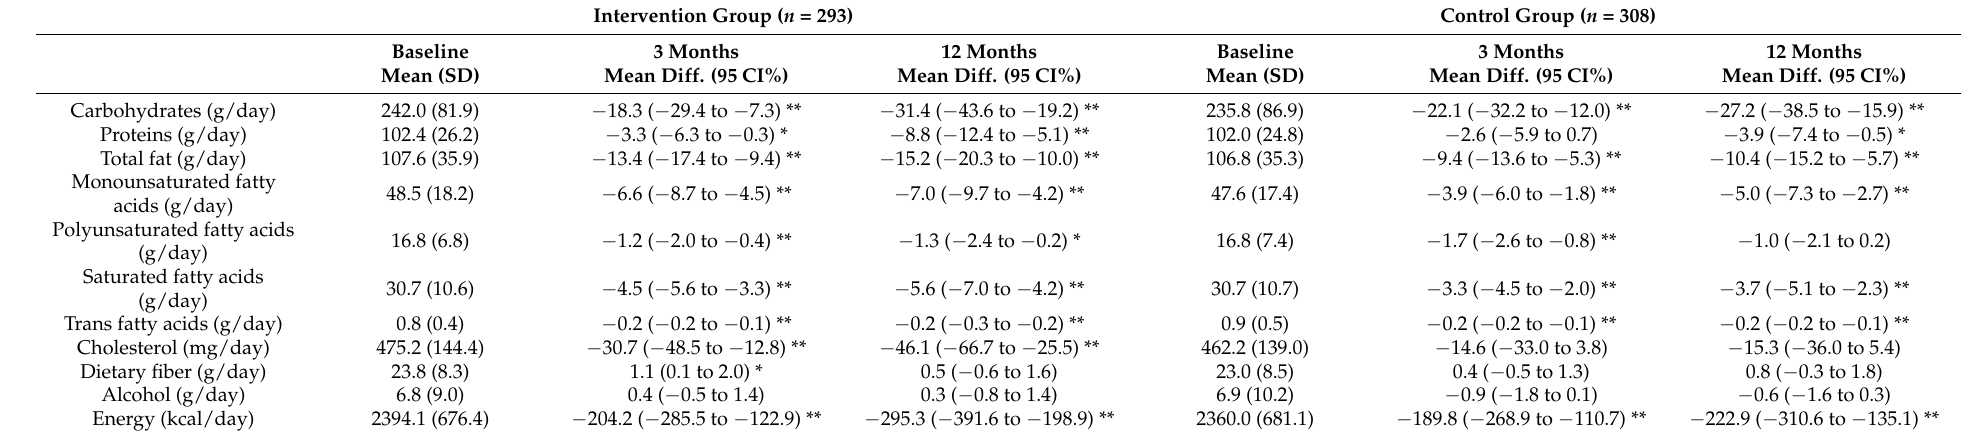
Table 2. Changes in macronutrients and energy intake throughout the